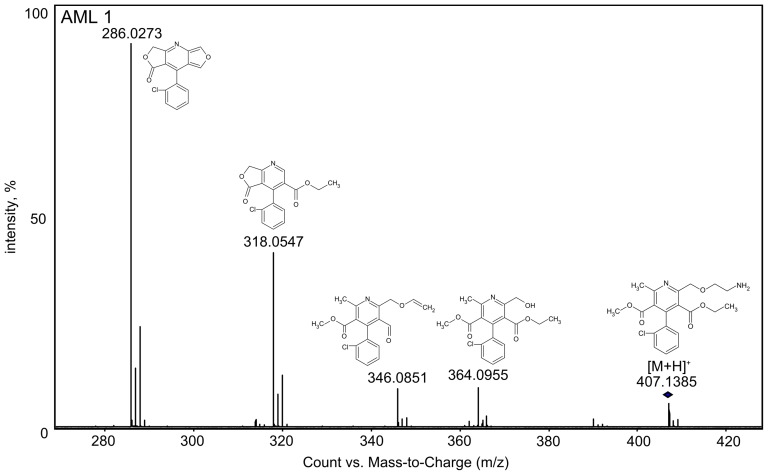
MS/MS spectrum of AML 1 with proposed structures of each fragment ion.